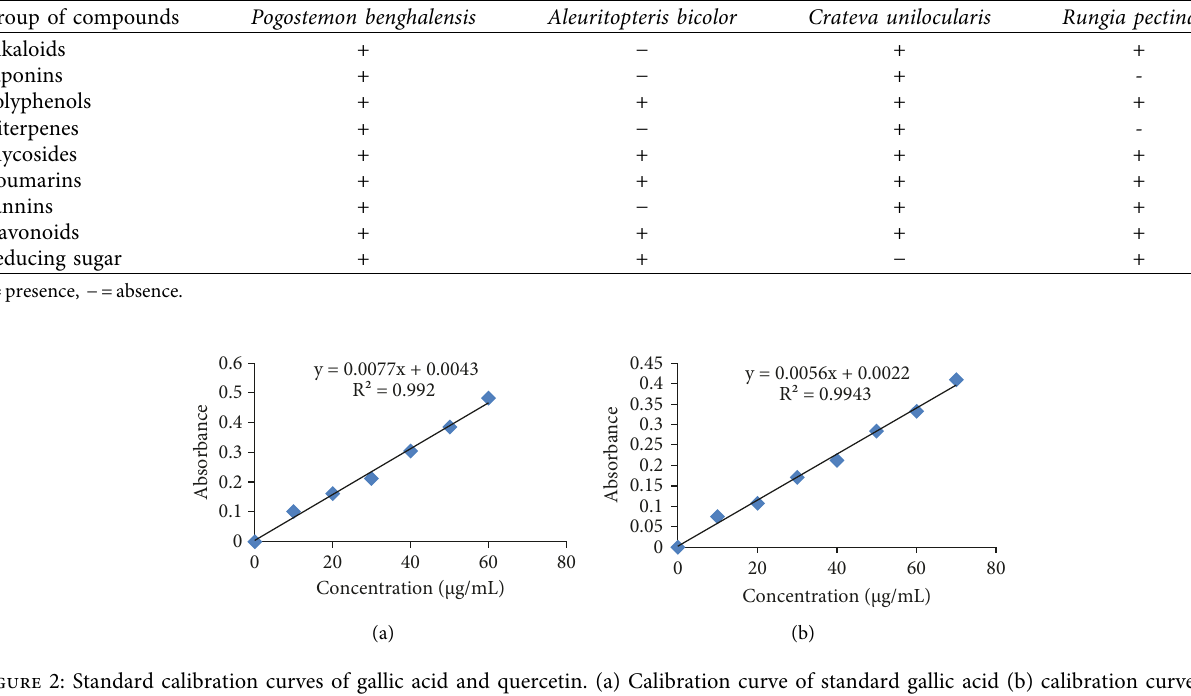
Figure 2: Standard calibration curves of gallic acid and quercetin. (a) Calibration curve of standard gallic acid (b) calibration curve of standard